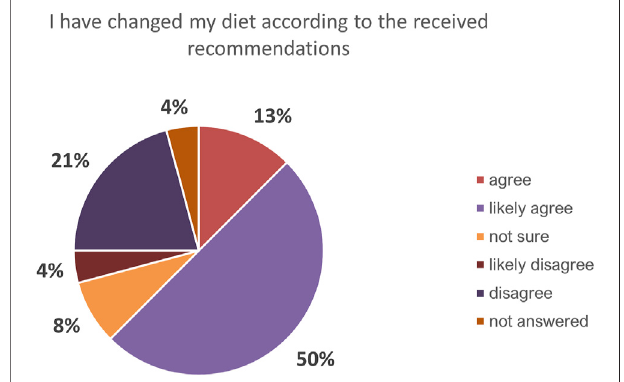
FIGURE 7 | Overview of the feedback to question “ How have you changed your habits after receiving information on the genetic variant you carry? ” in regard to changes in